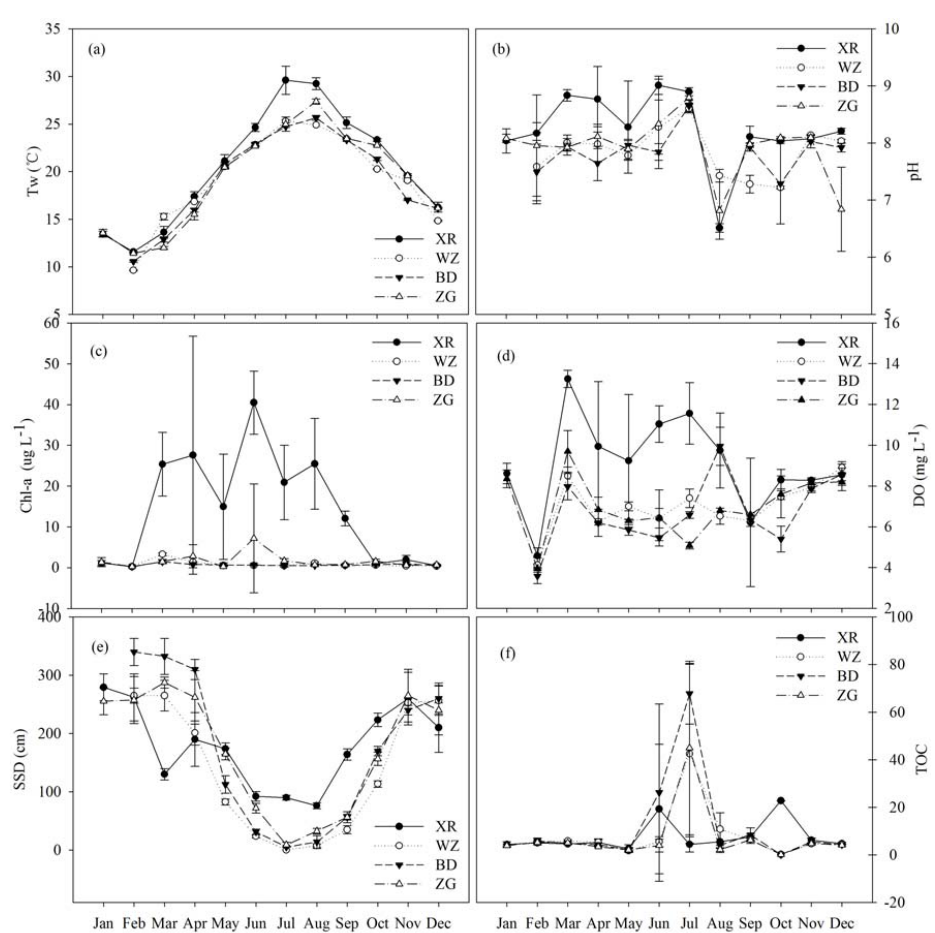
Fig. 4. Seasonal variation of water quality parameters from January to December. All designations are the same as those in Fig. Figure 4. Seasonal variation of water quality parameters, from January to December. All 608 designations are the same as those in Figure 1. 609